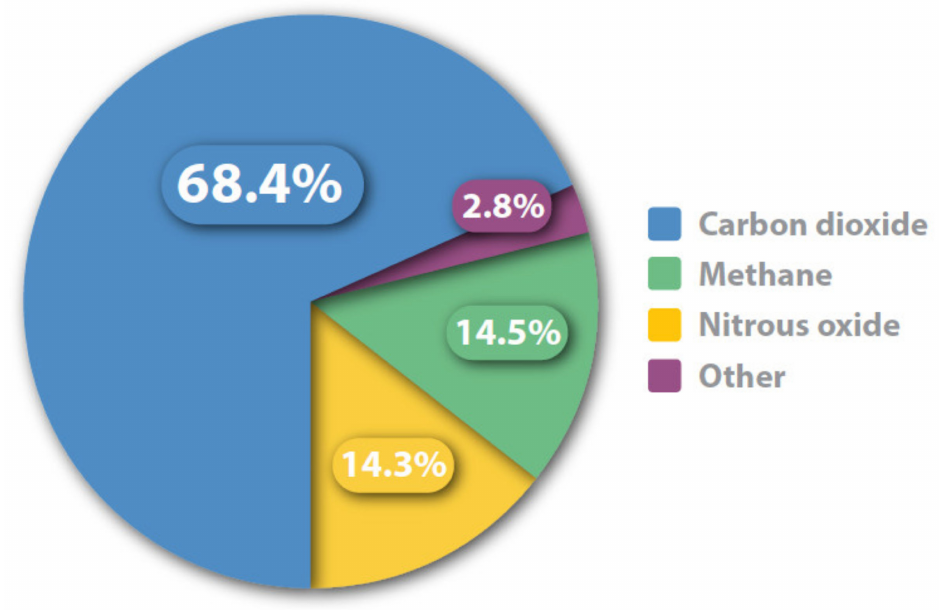
Figure 9. Lithuanian greenhouse gas emissions by gas in 2019.